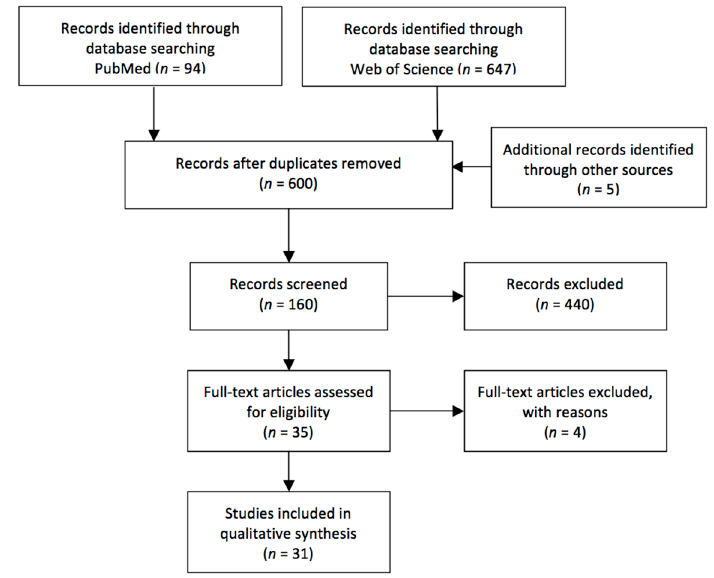
Figure 1. PRISMA flow chart